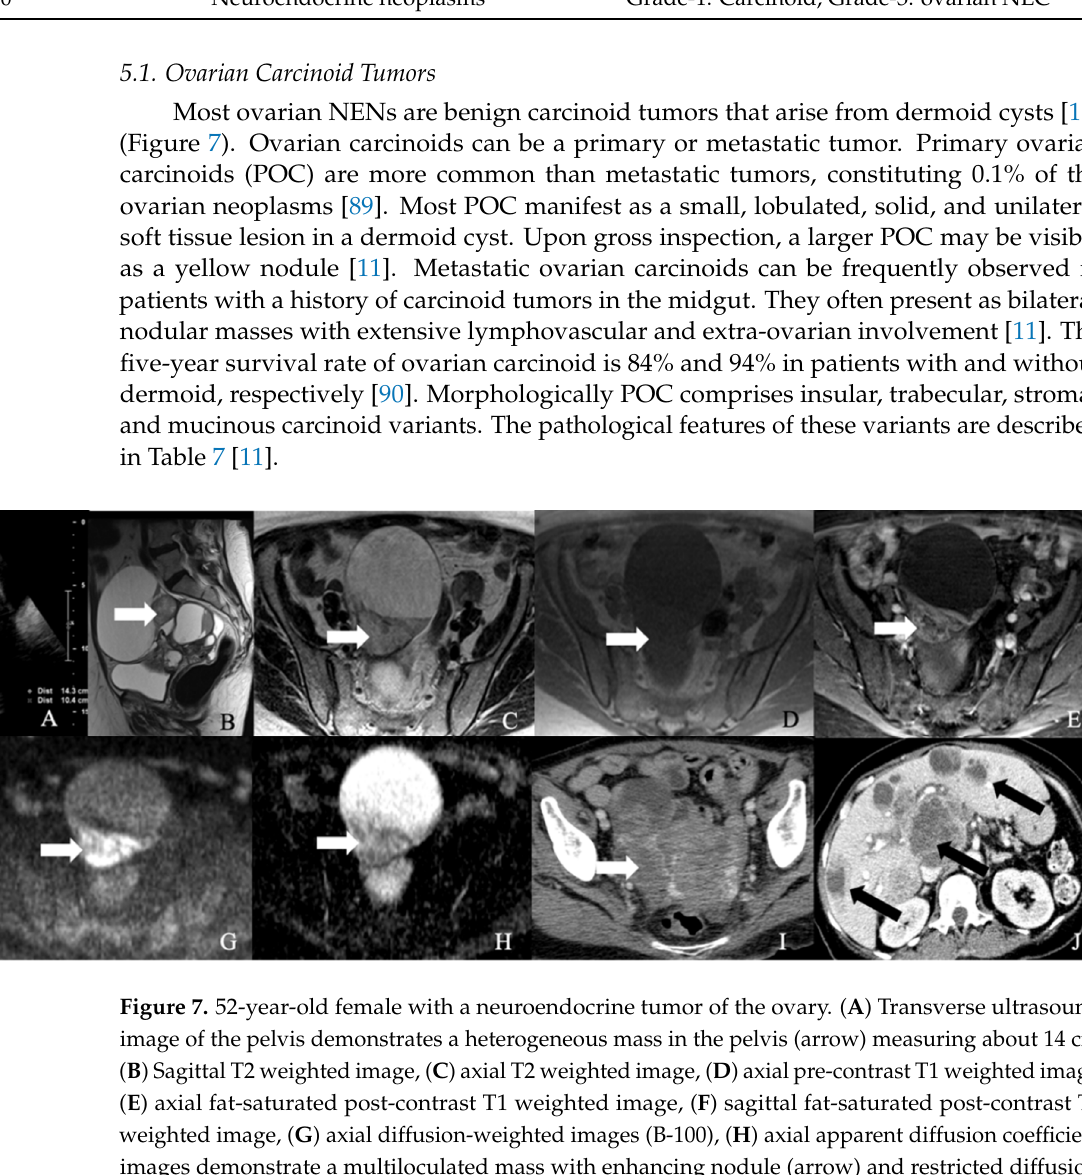
Table 7. Variants of ovarian carcinoid tumors and their pathological and immunohistochemical fea- tures.